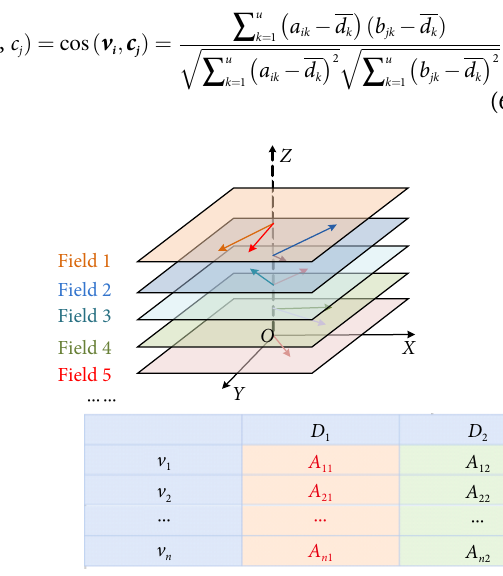
Fig. 1 Decision-maker matrix construction